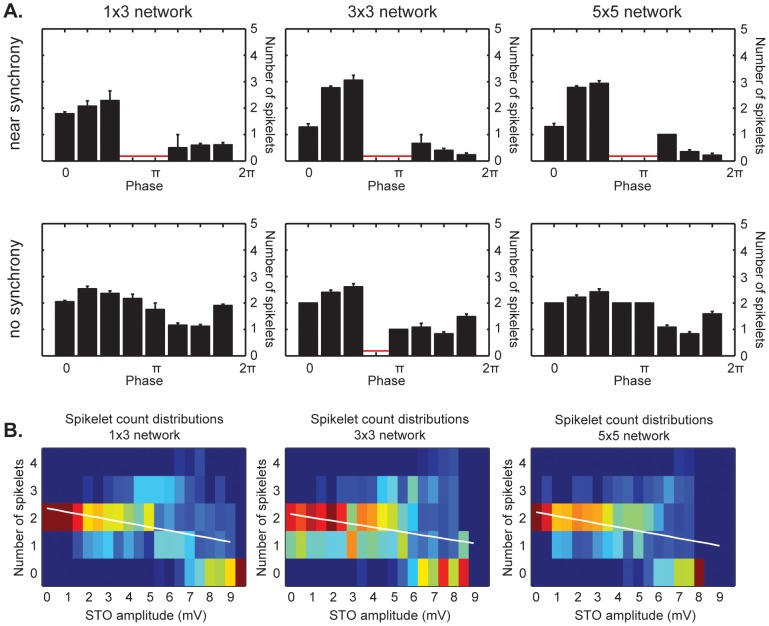
Effects of network synchrony on AP spikelet count.
A. Phase dependency of AP spikelet count for different network sizes when a network consists of coupled cells with near-synchronized STOs (STO amplitude >5.5 mV, top row) or non-synchronized STOs (STO amplitude <5.5 mV, bottom row). Phase ranges where no spikes were fired are indicated in red. Top row, near synchrony - The small 1×3 network shows a weak phase dependency of the AP spikelet count, averaging 0.5 spikelets on the upward slope of the STO and 2 spikelets around the peak. The 3×3 and 5×5 networks show similar outcomes and a stronger phase-dependency of the AP spikelet count, averaging 0 spikelets on the upward slope, followed by 1 spikelet near the peak and 3 spikelets around the peak. Due to a strong depolarizing current (5 pA, 20 ms for 1×3 networks and 6 pA, 20 ms for 3×3 and 5×5 networks, see Methods), spikes are sometimes fired outside the usual firing window in the trough of the oscillation (1.25π radians bin, total of 7 occurrences in 2100 simulations across all network sizes). Bottom row, no synchrony - Regardless of network size, there is no clear phase-dependency of AP spikelet count. A rounded average of 2 spikelets is seen across all phases, except for part of the phase range falling outside or close to the bounds of the firing window where a rounded average of 1 spikelet may occur. Due to analysis restrictions imposed by determining the phase, STO amplitudes smaller than 1 mV are poorly represented in the data set. B. AP spikelet distributions across STO amplitudes for different network sizes. Warmer colors denote more occurrences, cooler colors less. The distribution of spikelets changes as a function of STO amplitude. In a range of approximately 5 to 7 mV, the distribution broadens, corresponding with the phase dependency of AP spikelet counts shown in panel A. At an STO amplitude of 7.5 mV or more, this distribution narrows again, but at a lower average spikelet count than was seen at lower amplitudes. The average number of AP spikelets shows a downward trend for all network sizes, as illustrated by the fitted trend lines shown in white.